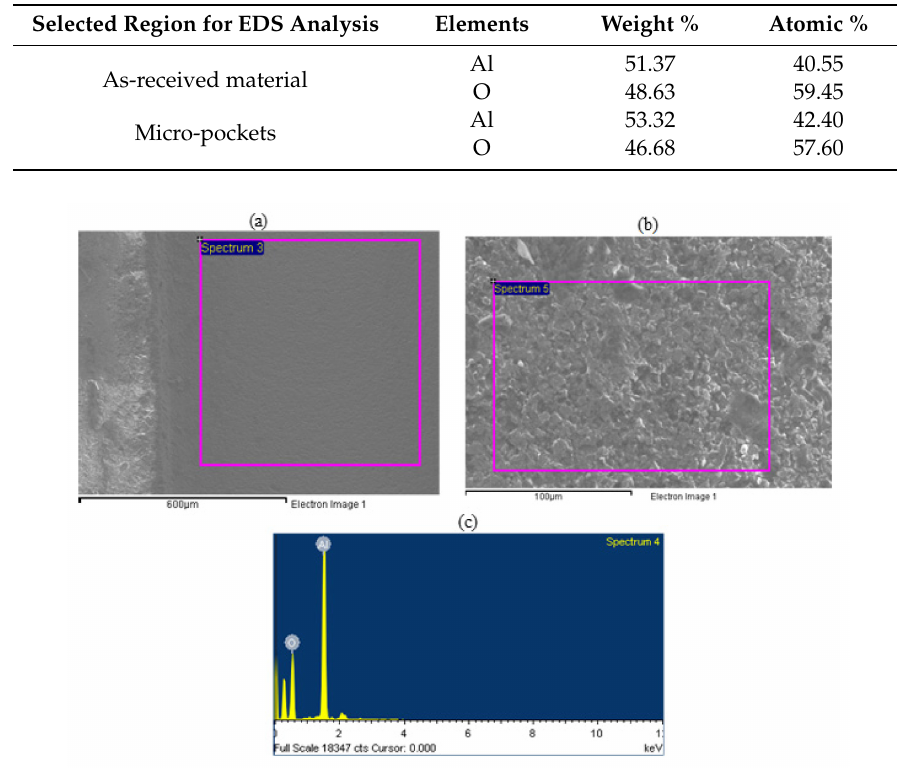
Table 7. Comparison of the chemical composition of as-received material and the machined